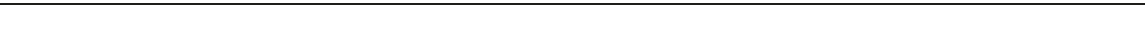
Fig. 3 PIP5K1A binds speci fi cally to KRAS G12V . a Plots of proximity labeling by myc-tagged BirA* fused to (top), and sgRNA enrichment scores in cells transformed with (bottom), KRAS G12V (black triangle), NRAS G12V (orange square), or BirA*-HRAS G12V (blue circle) for the indicated 19 kinases. b , c Immunoblot detection of the indicated immunoprecipitated (IP) and co-immunoprecipitated (CO-IP) myc-RAS G12V and PIP5K1A-V5 proteins. n = 2. d Immunoblot detection of IP endogenous KRAS with CO-IP endogenous PIP5K1A from SW620 cells. n = 1. e Recombinant GST-PIP5K1A and